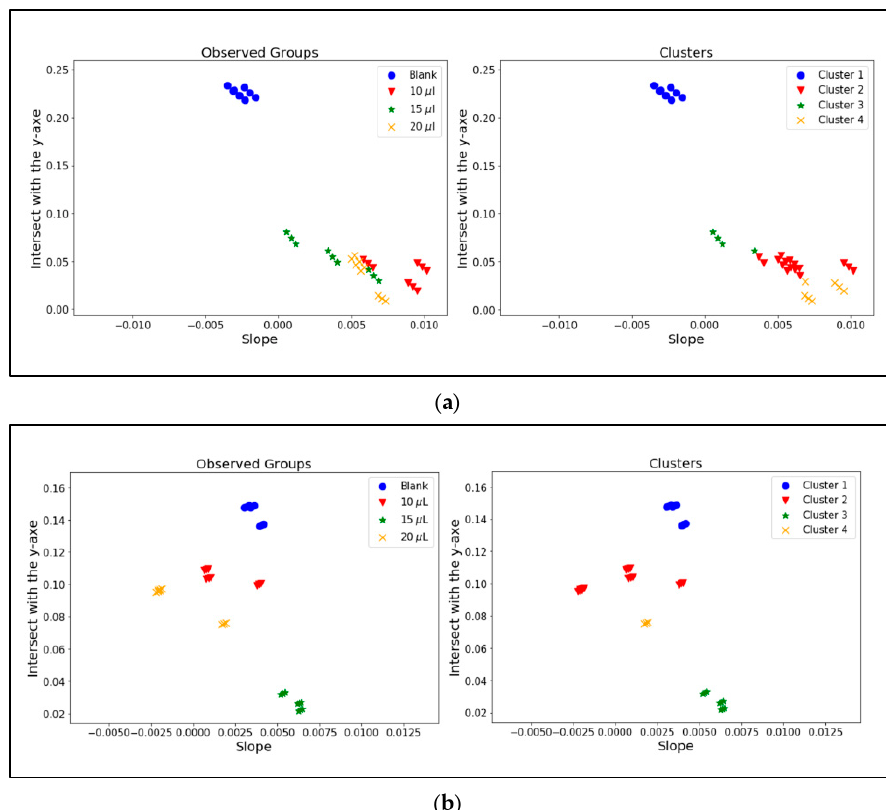
Figure 3. Cluster correlations of Mn ( a ) and Pb ( b ) results for hair samples.